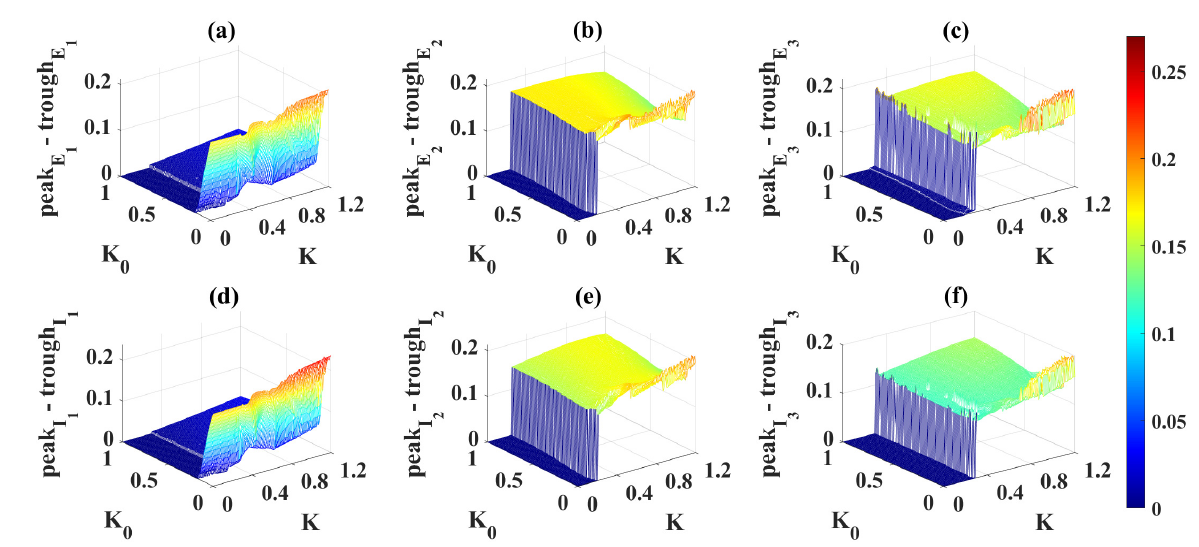
Figure 13. Dynamical responses of the three columns (( a , d ): column1, ( b , e ): column2, ( c , f ): column3) under the influence of different coupling strengths K and electromagnetic induction feedback gains K 0 . The electromagnetic induction applied in column1 appears to be unable to control column2 ( b , e ) and column3 ( c , f ), which are in an epileptic state due to the propagation